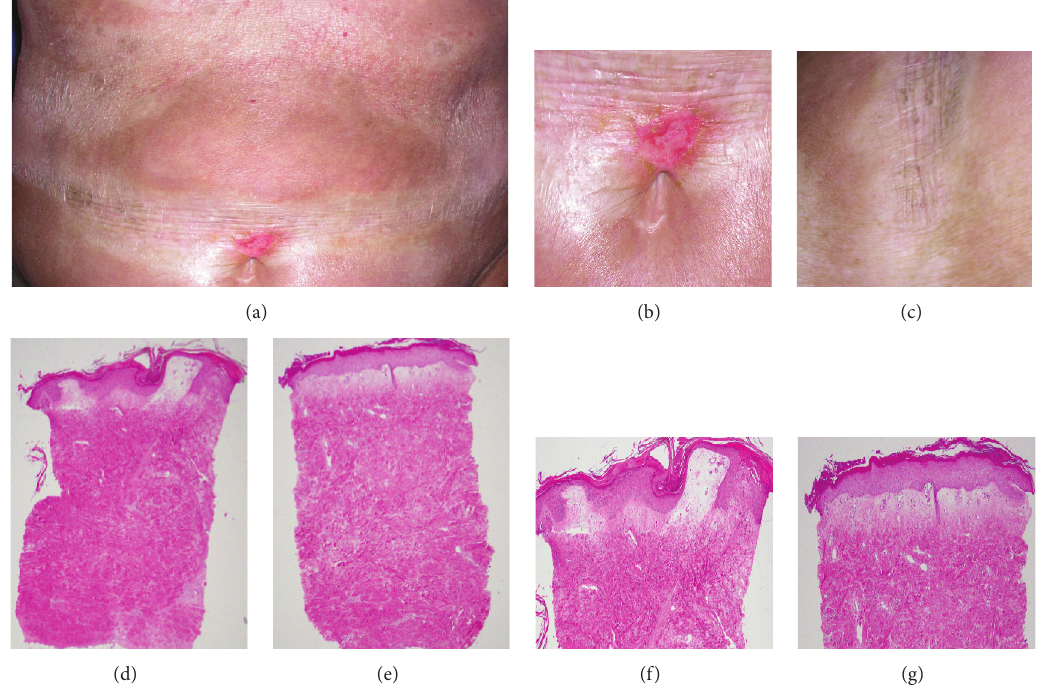
Figure 1: Clinical and dermatopathological findings in a patient carrying a novel LEMD3/Man1 (Trp620X) mutation. (a–c) Morphea lesions. (a) Skin lesions involving abdomen. Note indurated periumbilical skin. (b) Close-up highlighting ruptured periumbilical bulla. (c) Indurated skin on chest. (d–g) Histopathology from lesional skin. (d, f) Abdominal skin, H&E, 20x (d) and 50x (f). (e, g) Chest skin, H&E stain 20x (e) and 50x